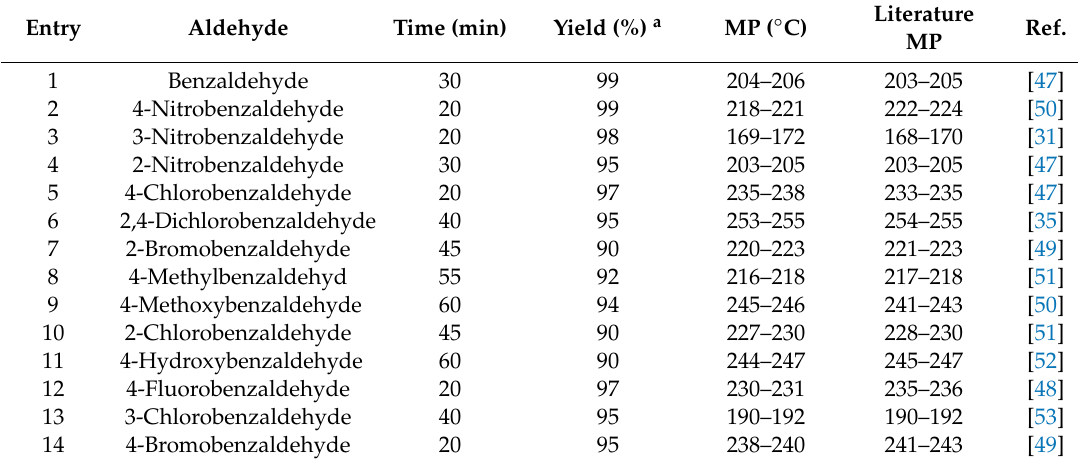
Table 2. Preparation of 1,8-dioxo-octahydroxanthene a derivatives using Fe@SBA-15 as catalyst.